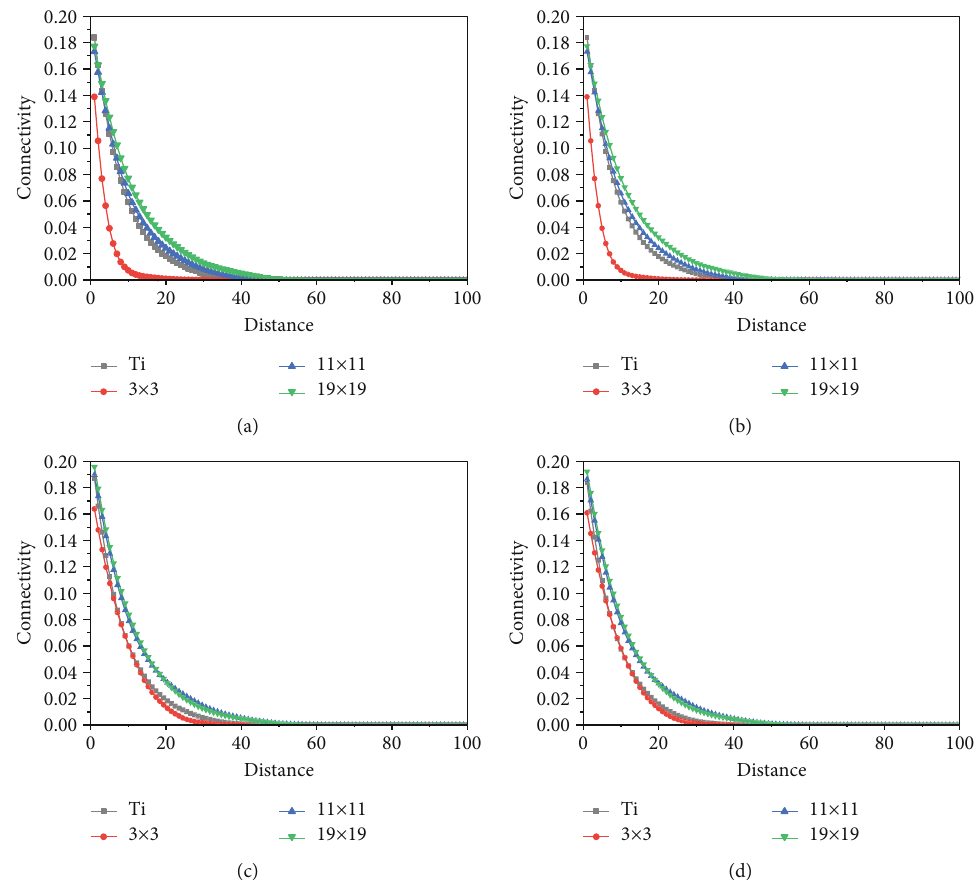
Figure 10: Curvilinear connectivity of pore: (a) single-grid scheme x direction; (b) single-grid scheme y direction; (c) multiple-grid scheme x direction; (d) multiple-grid scheme y